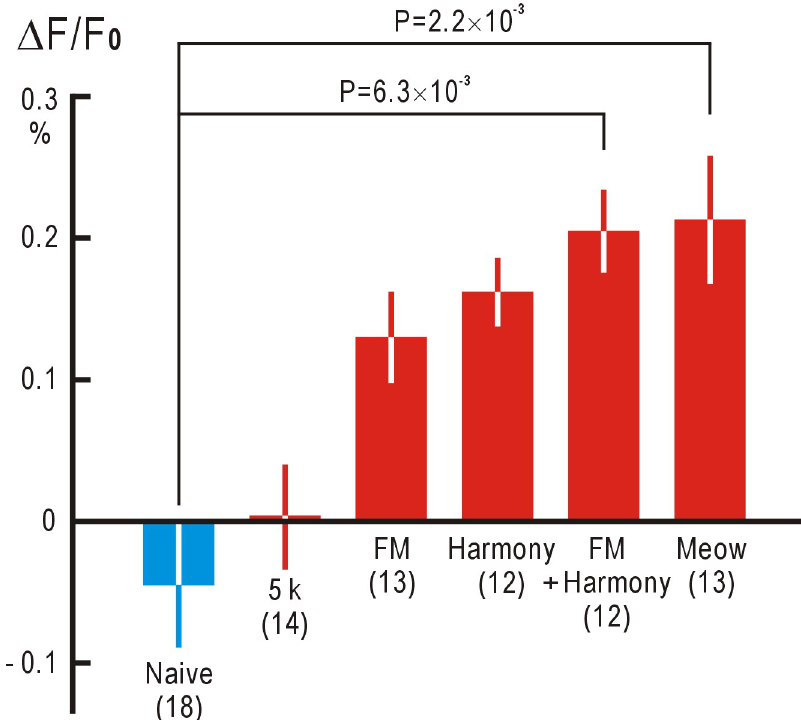
Fig 4. Associative auditory responses in the AC to visual stimuli. Amplitudes of the associative responses to a 5 kHz pure tone, FM tone, harmonic tone, FM harmonic tone, and a “meow” sound (red columns). Columns with lines show means and SEMs. Concentric circles and stars were used as visual shape stimuli. Amplitudes of control responses with no pre-exposure are shown by a blue column.